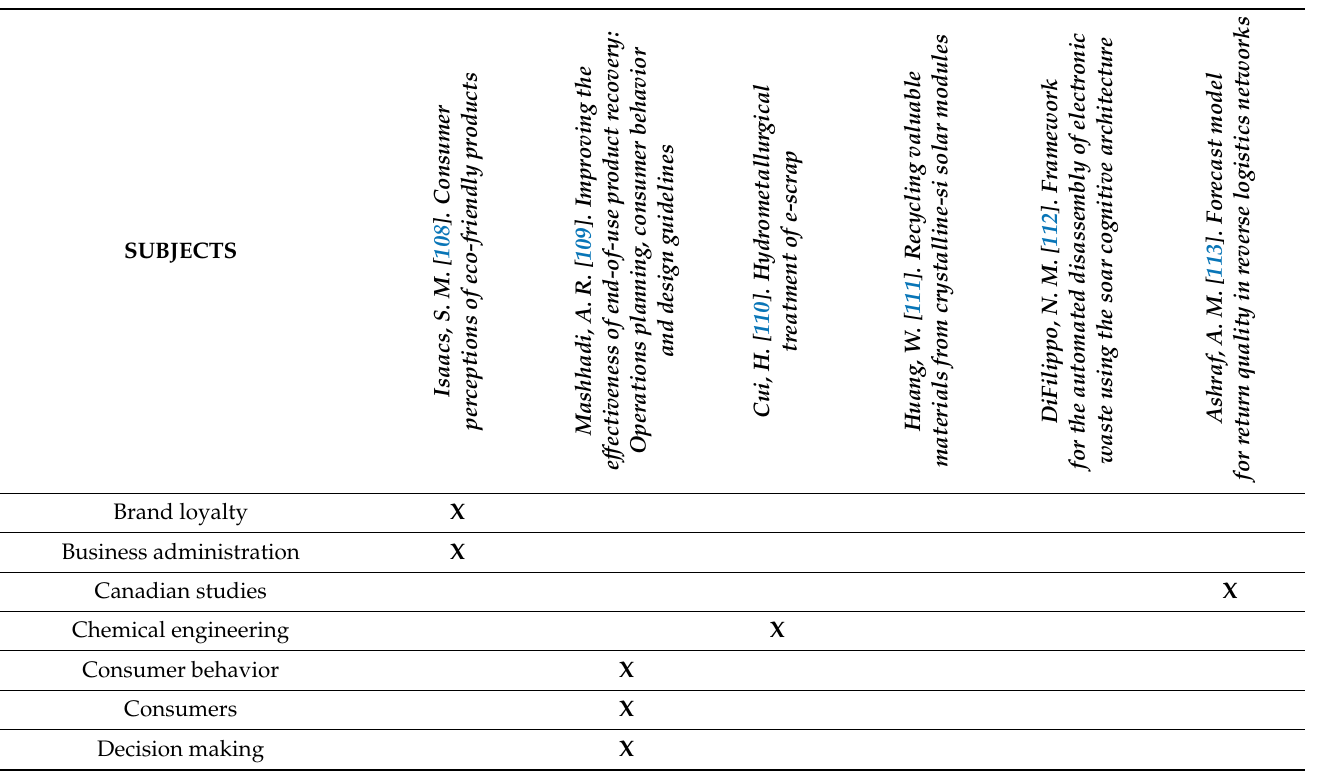
Table 5. Subject areas defined by ProQuest for six doctoral